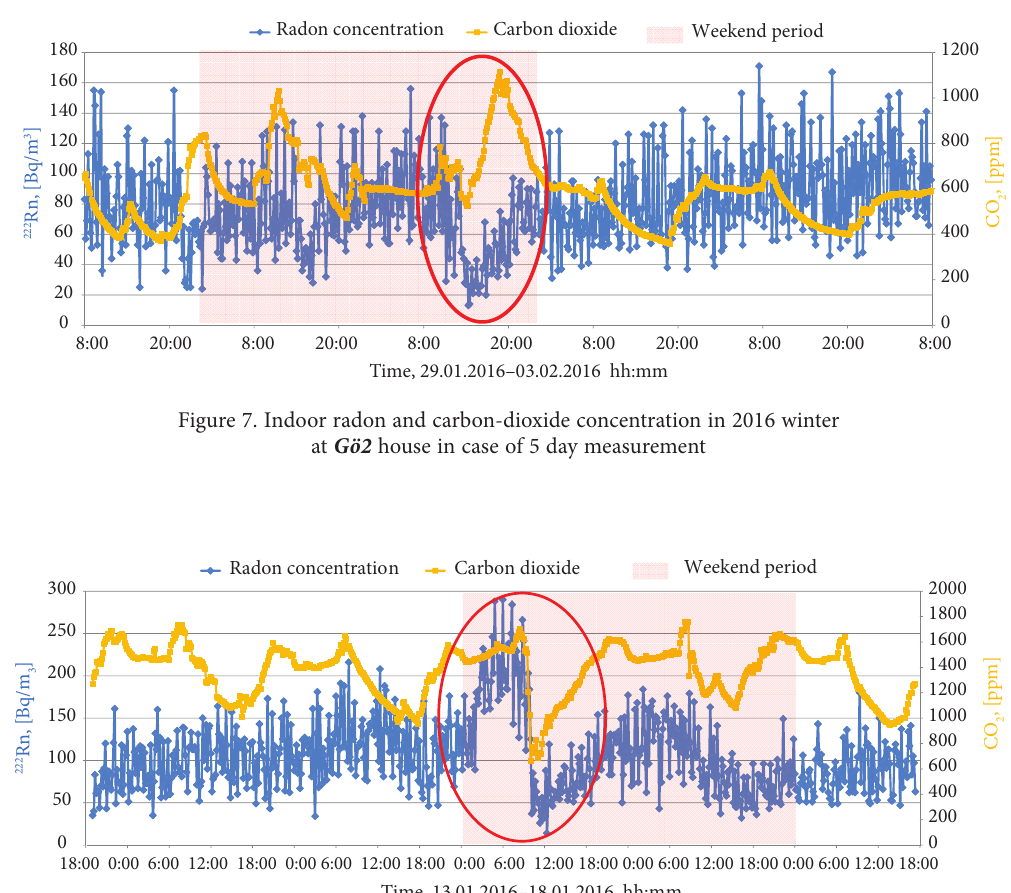
Figure 8 charts house Gö1 during a 5 day period